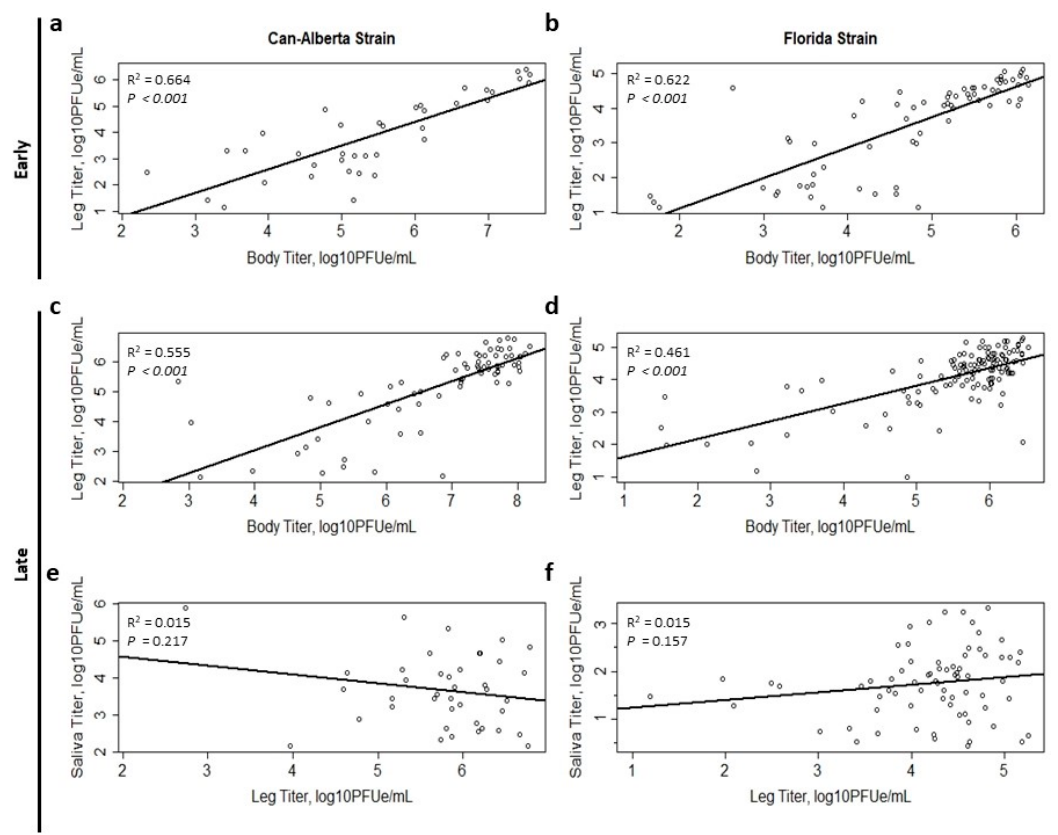
Figure 2. Viral titer relationships between bodies, legs, and saliva of C. sonorensis infected with two strains of EHDV-2. ( a ) Body by leg titer correlation for Can-Alberta, ( b ) body by leg titer correlation for Florida strain, ( c ) body by leg titer correlation for Can-Alberta, ( d ) body by leg titer correlation for Florida, ( e ) leg by saliva correlation for Can-Alberta, ( f ) leg by saliva correlation for Florida. Figure 2a,b show correlations during the early period (days 3–7 post-feeding) and Figure 2c–f show correlations during the late period (days 8–13 post-feeding).